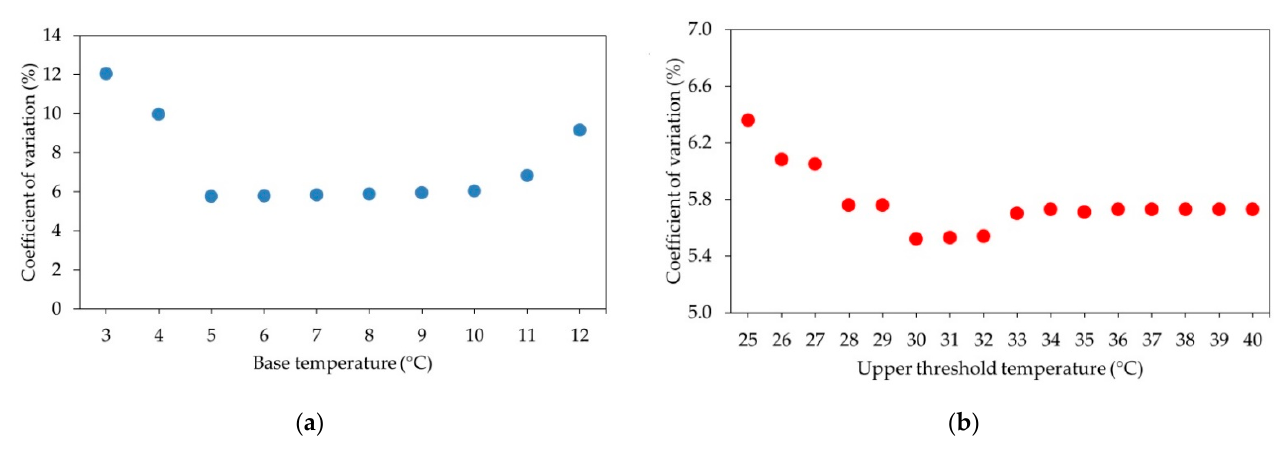
Figure 1. Coefficient of variation (CV) in growing degree days (GDD) for the period between bud break and harvest at various base temperatures ( a ) and upper threshold temperatures ( b ). Data set from five seasons.